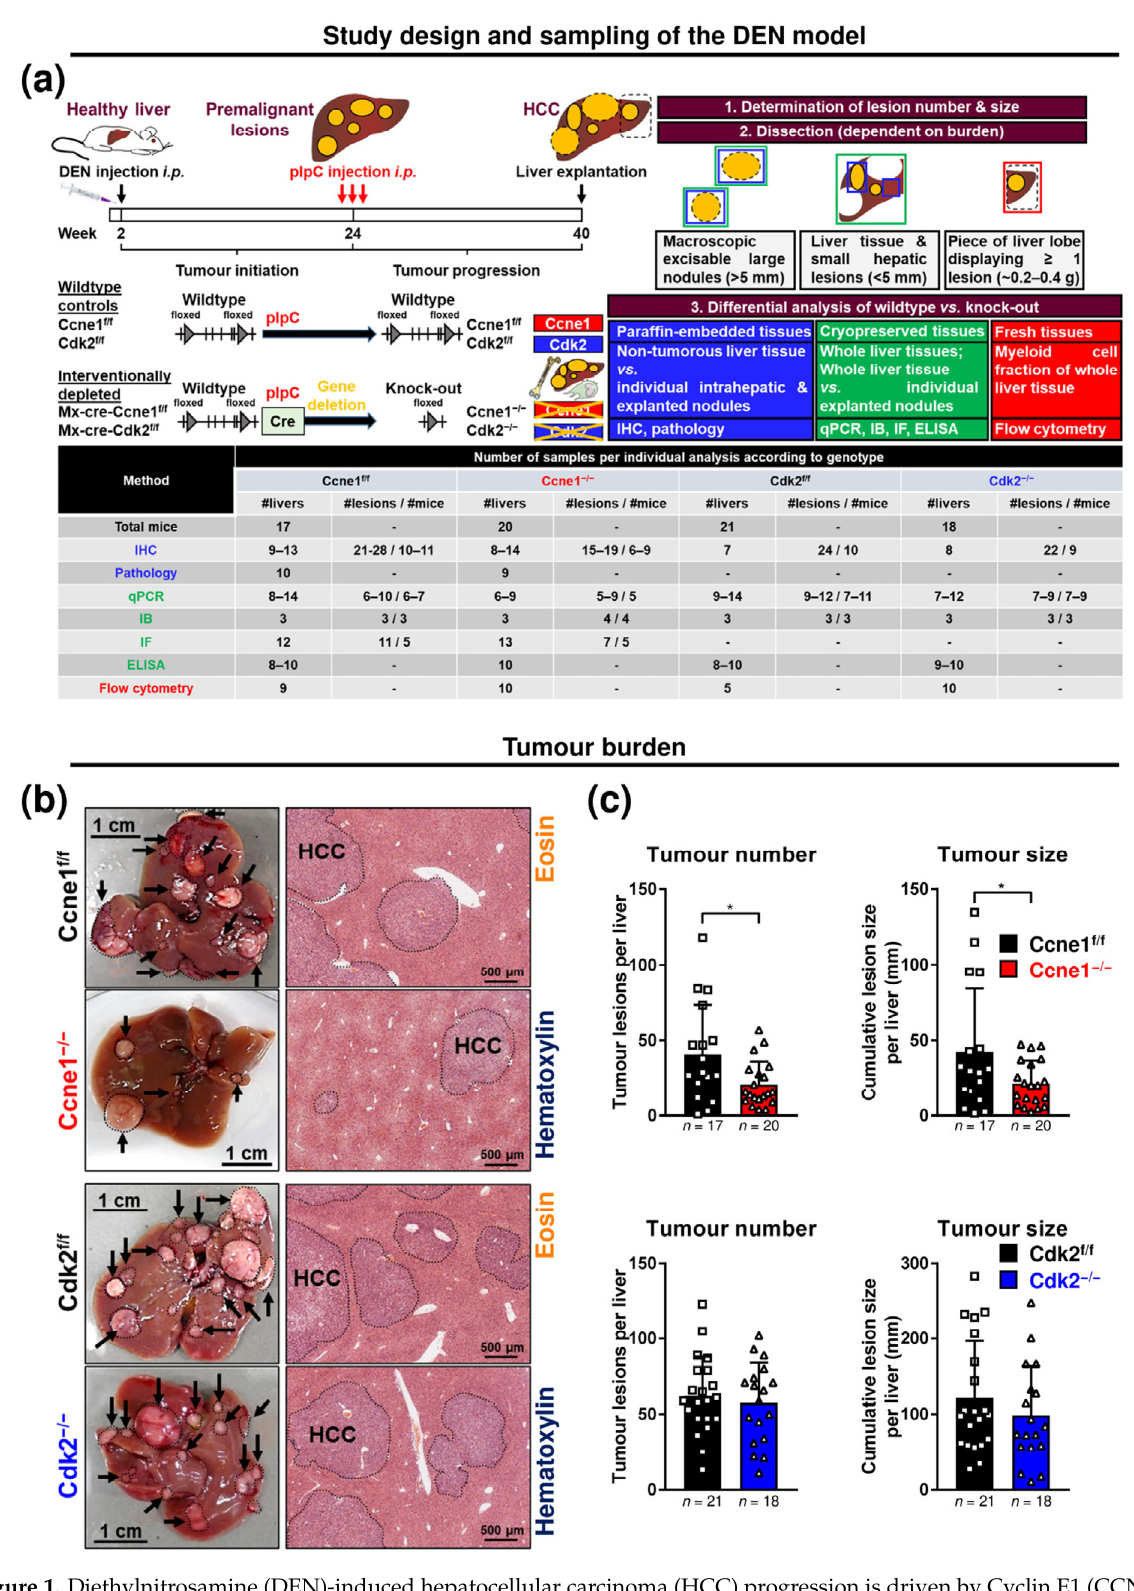
Figure 1. Diethylnitrosamine (DEN)-induced hepatocellular carcinoma (HCC) progression is driven by Cyclin E1 (CCNE1) independent of Cyclin-dependent kinase 2 (CDK2). ( a ) Experimental setting of the interventional HCC model. Top: Mx-Cre -transgenic mice and Mx-Cre -negative littermates with loxP-flanked (floxed, f/f) Ccne1 or Cdk2 allele were once treated intraperitoneally (i.p.) with the hepatocarcinogen DEN at the age of two weeks. After 22 weeks (tumour initiation), mice developed macroscopically visible premalignant liver lesions, which progressed to solid HCC until week 40 (tumour progression). All mice received three injections of